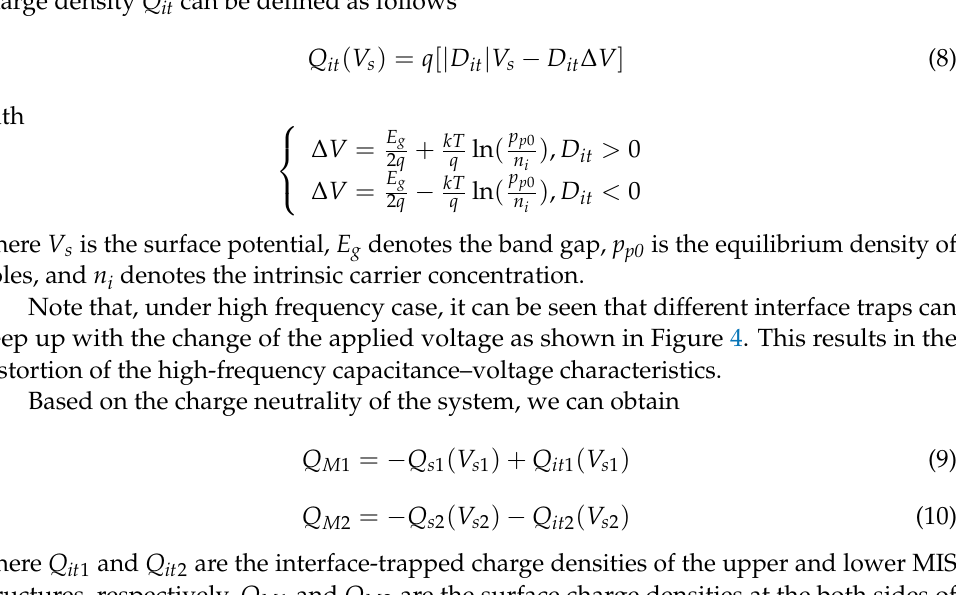
Figure 3. Energy-band diagram of a staked bonding structure at flat band.